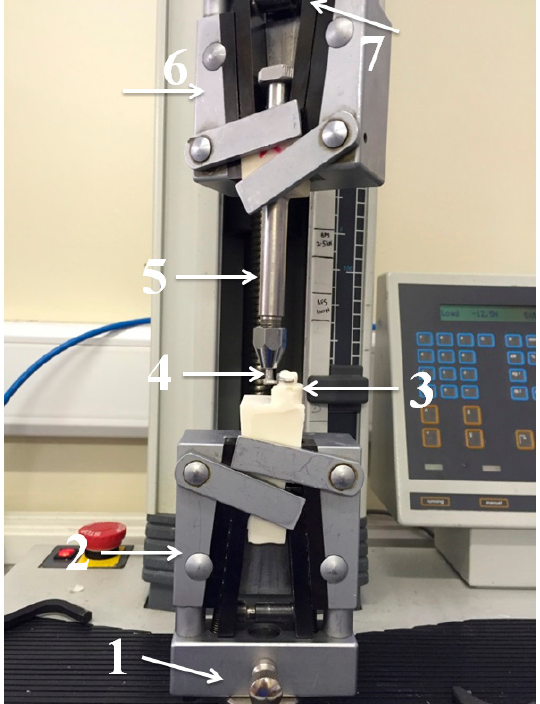
Figure 6 . Cycling test. ( 1 ) Lower position; ( 2 ) lower part; ( 3 ) abutment crown with holder; ( 4 ) clasp with holder; ( 5 ) metallic holder; ( 6 ) upper part; and ( 7 ) upper position.